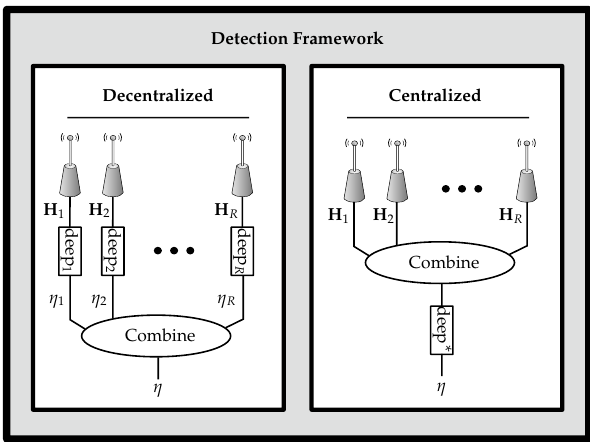
Figure 2. Proposed detection